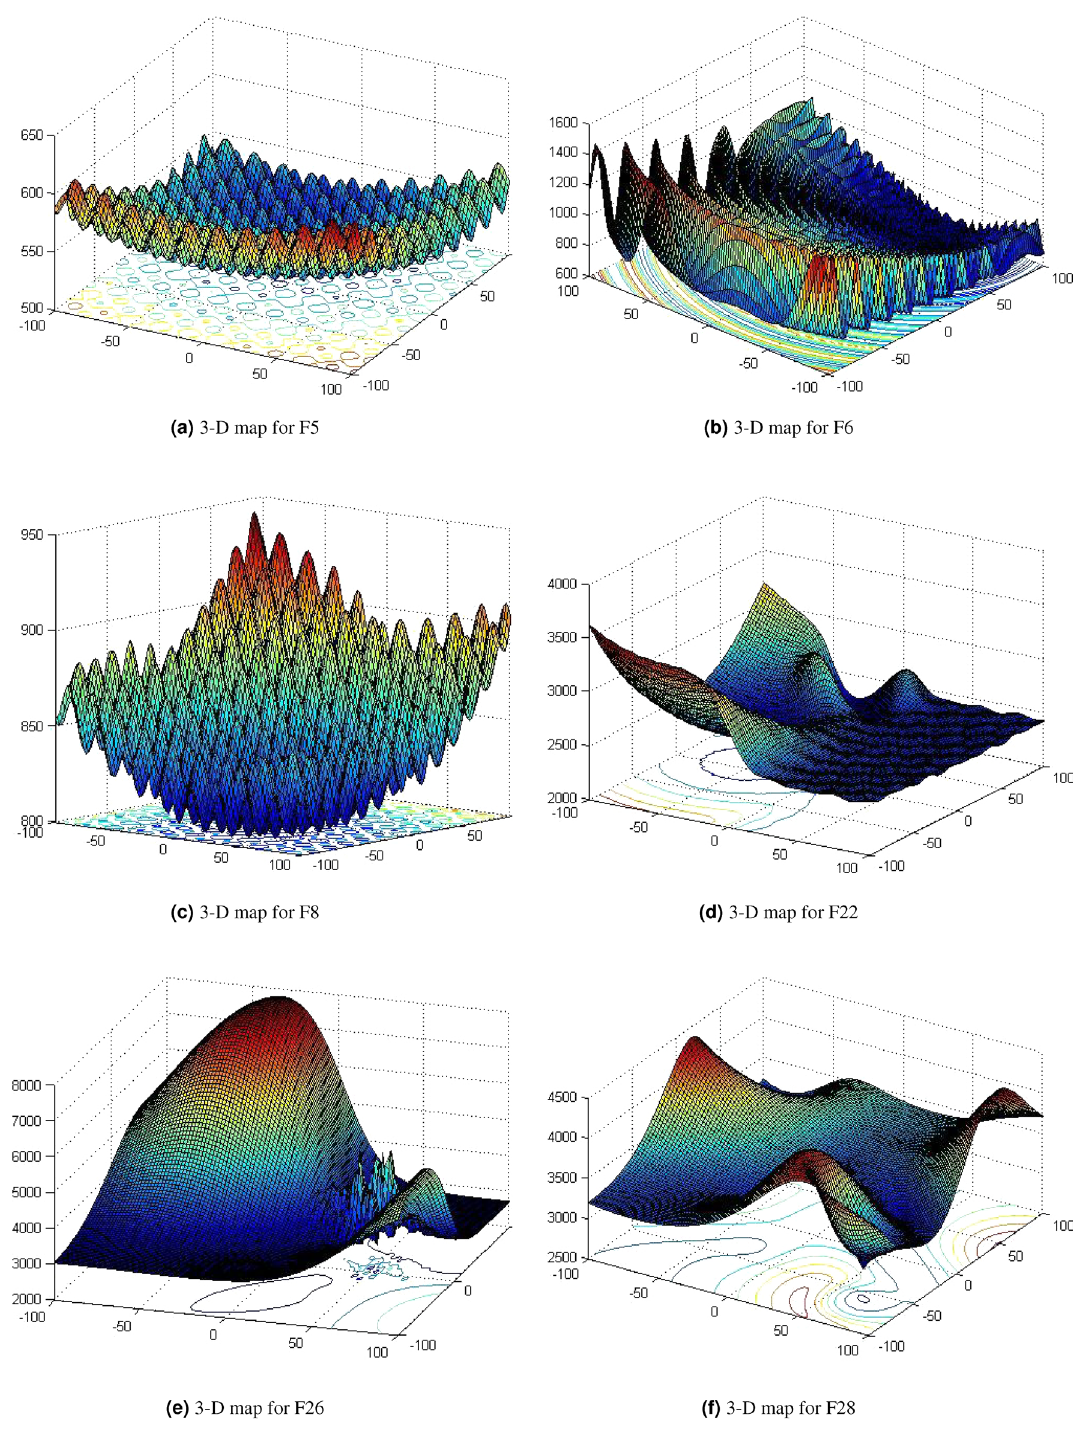
Figure 2. 3-D graphs of CEC’2017 test